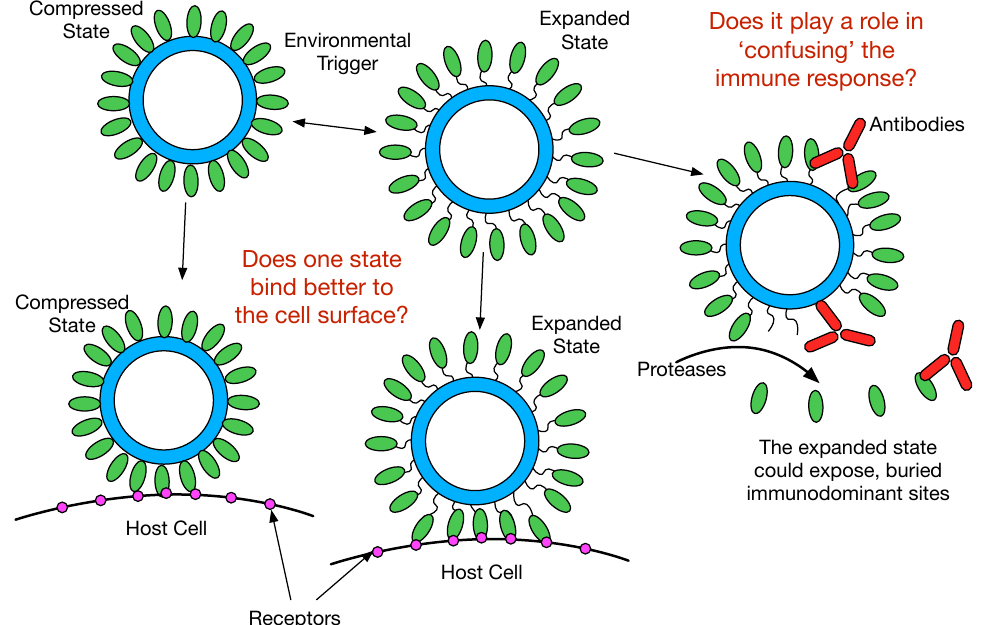
Figure 5. Possible roles for the conformational flexibility of the P domains with respect to the shell. The biological role for the compressed/expanded state transition is unknown. This figure shows some possibilities. In the expanded state, the P domain lifts off the shell by at least 16Å and rotates by nearly 90 ◦ . This change in orientation and flexibility might favor cell surface binding of one state versus the other. This marked flexibility might expose antigenic sites observed in the expanded state but not the compressed state [23], making some antibodies non-neutralizing [27]. The flexibility of the linker may make it more susceptible to proteolysis, thereby creating a “smoke screen” or exposure of non-neutralizing